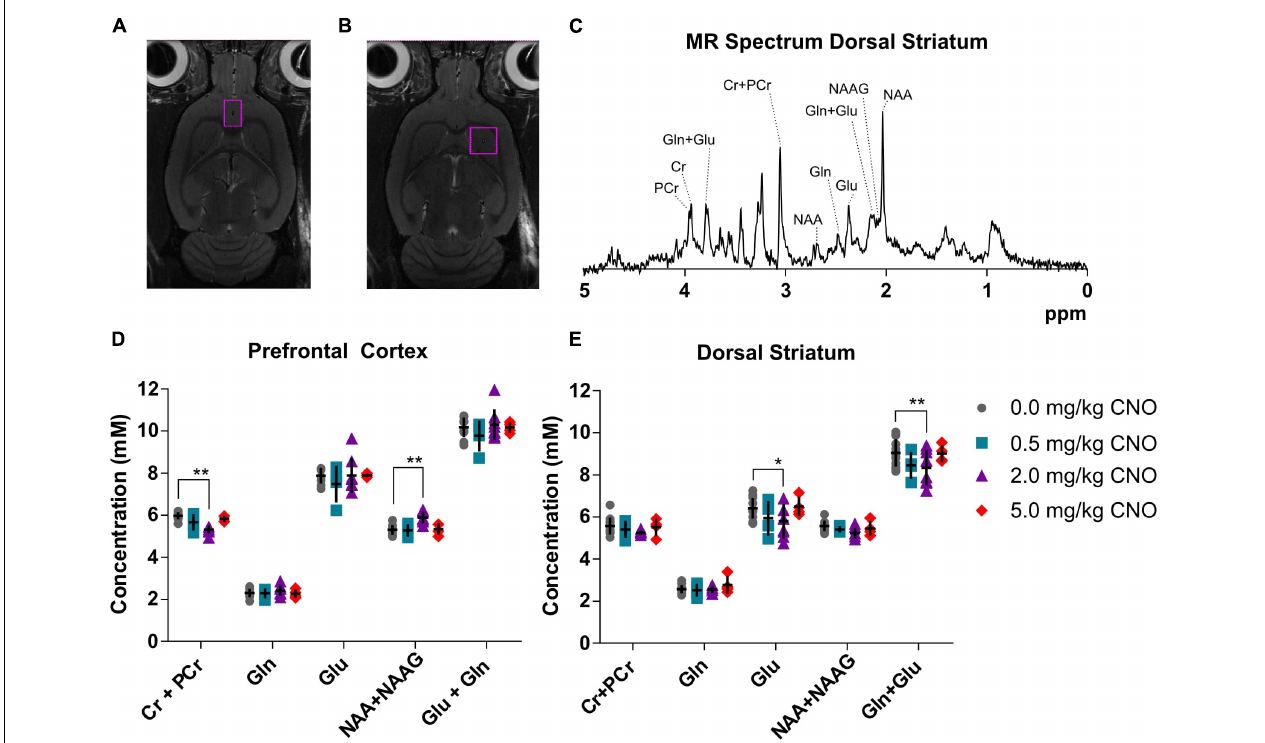
FIGURE 3 | Neurometabolite concentrations as measured in vivo using MR spectroscopy. Cubic voxels 18 µ L in the prefrontal cortex (A) and 27 µ L dorsal striatum (B) . A sample spectrum (C) from the voxel in the dorsal striatum and metabolite concentrations in the voxels following pretreatments with different doses of CNO in the prefrontal cortex (D) and in the dorsal striatum (E) . ∗ p < 0.05, ∗∗ p < 0.01 and ∗∗∗ p < 0.001 two-way ANOVA with Sidak’s multiple corrects